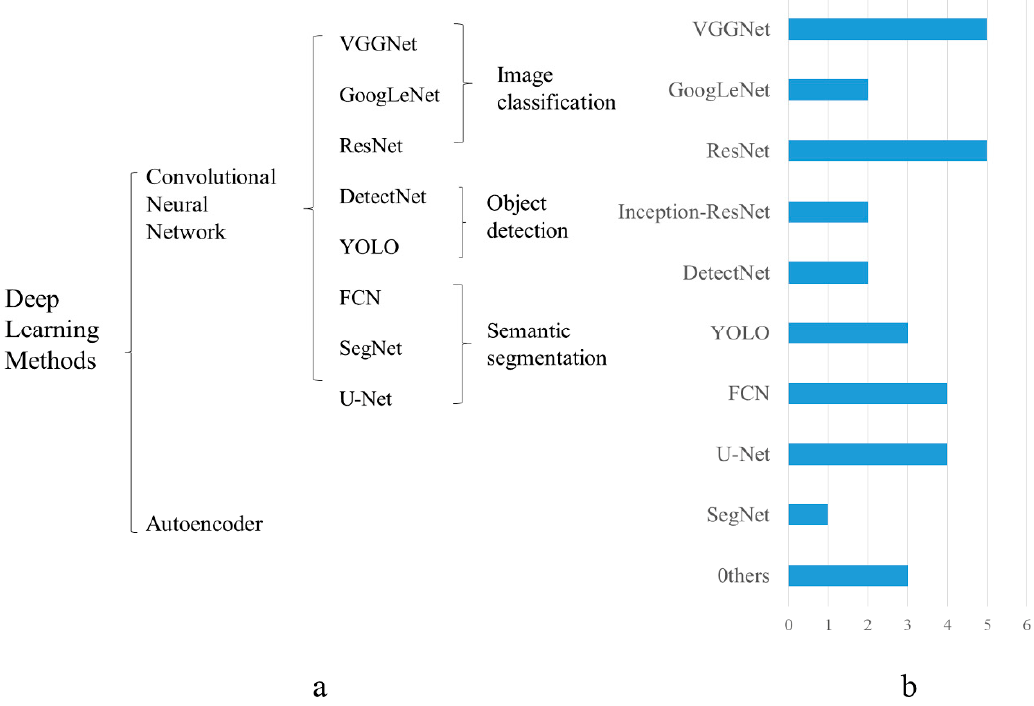
Figure 3. ( a ) Different architecture of Deep Learning (DL) Algorithms in dense agricultural scenes; ( b ) Uses of surveyed DL methods.